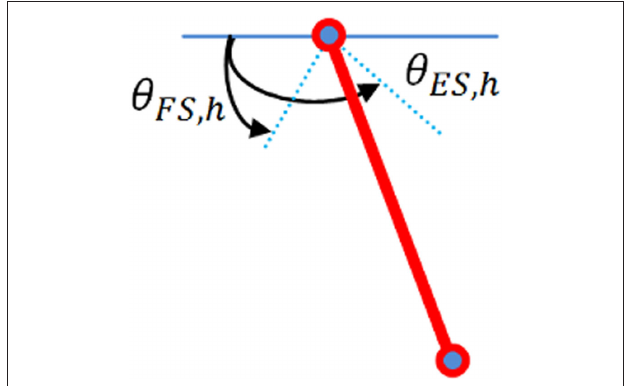
FiguRe 5 | Leg model for 1-DOF; weight and length of tibia are 1 kg and 0.20 m, respectively.